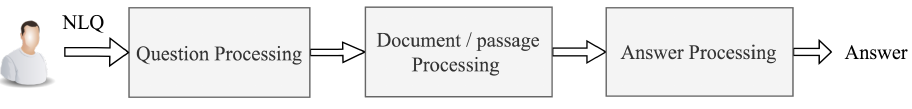
Figure 1. Basic architecture of a question answering